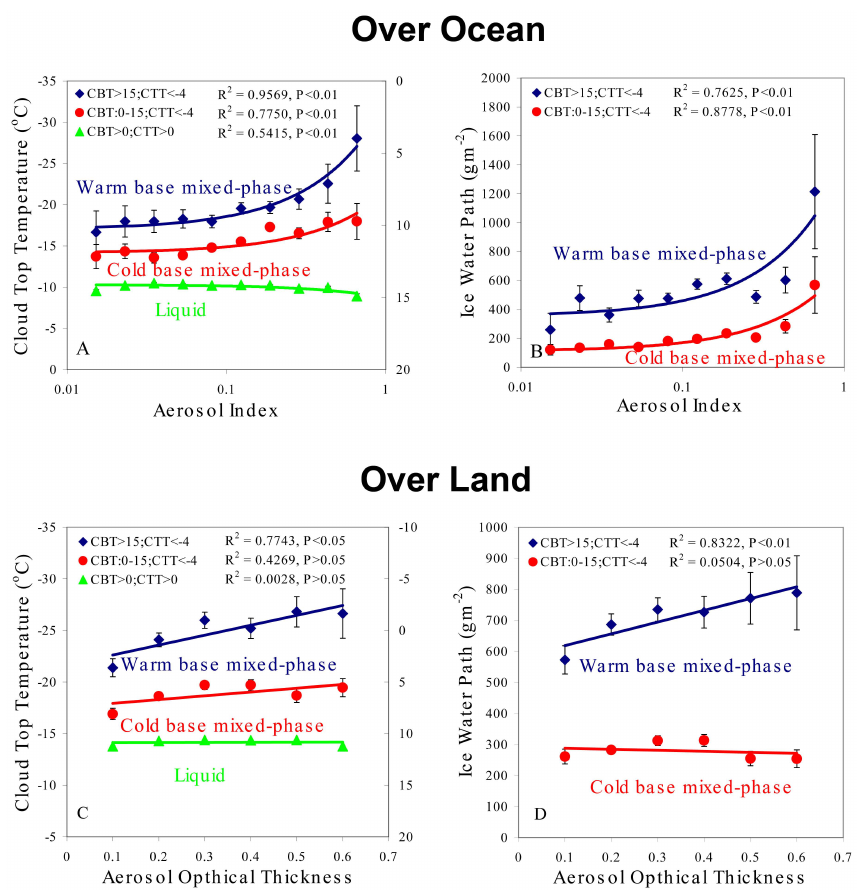
Fig. 1. Cloud-top temperature (A, C) and ice water path (B, D) as functions of AI/AOT for warm (blue dots) and cold (red dots) base mixed- phase clouds and liquid clouds (green dots) over ocean (upper panels ) and land (lower panels). The right-hand axes of (A) and (C) are for liquid clouds. The AI is plotted using a logarithmic scale. Linear regressions were performed on the averaged values of each bin. R 2 and P are the correlation coefficient and significance level according to a t-test for each type of clouds, respectively.